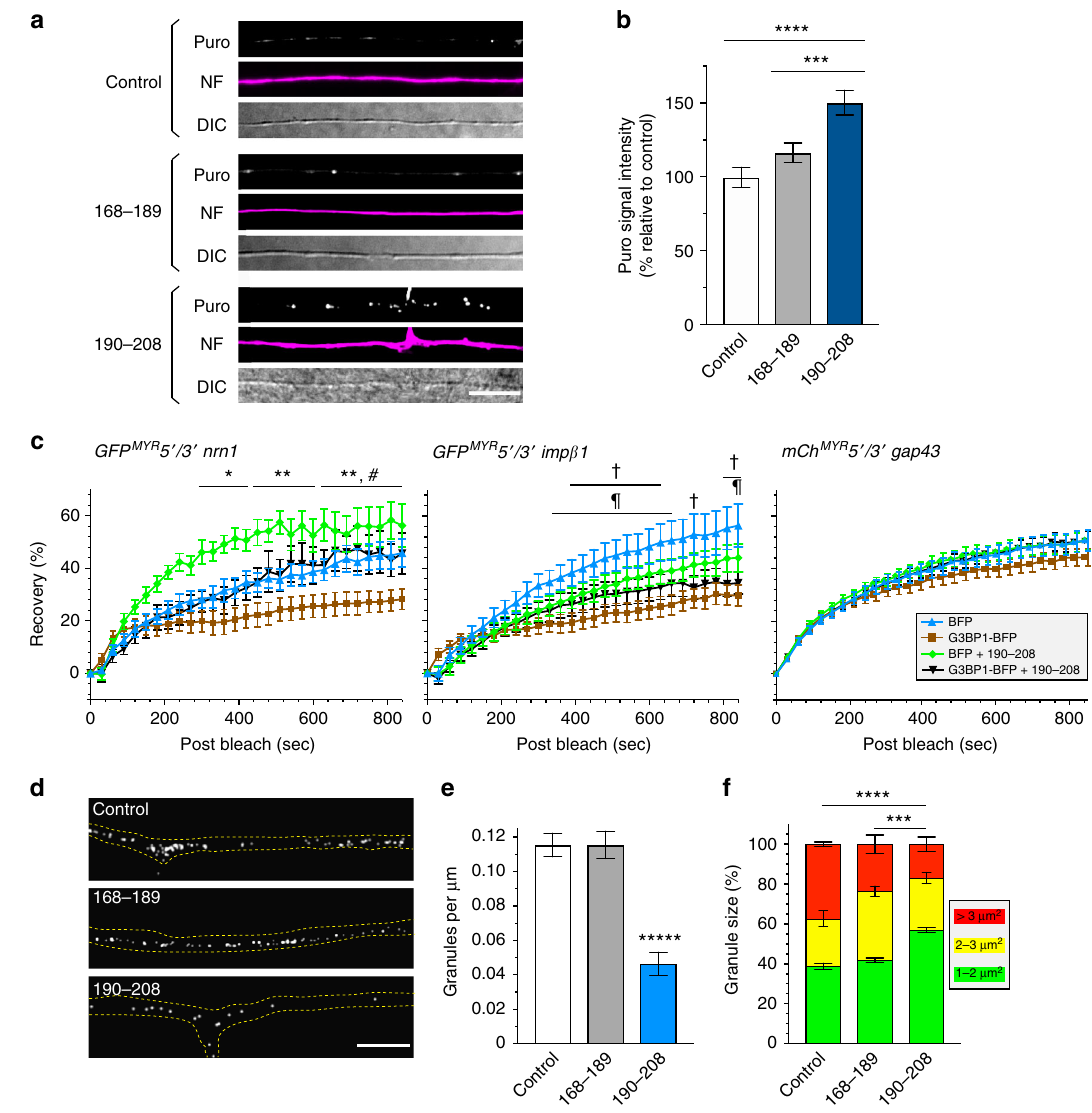
Fig. 6 Cell permeable G3BP1 190 – 208 peptide increases axonal mRNA translation and disassembles stress granules. a , b , Representative images